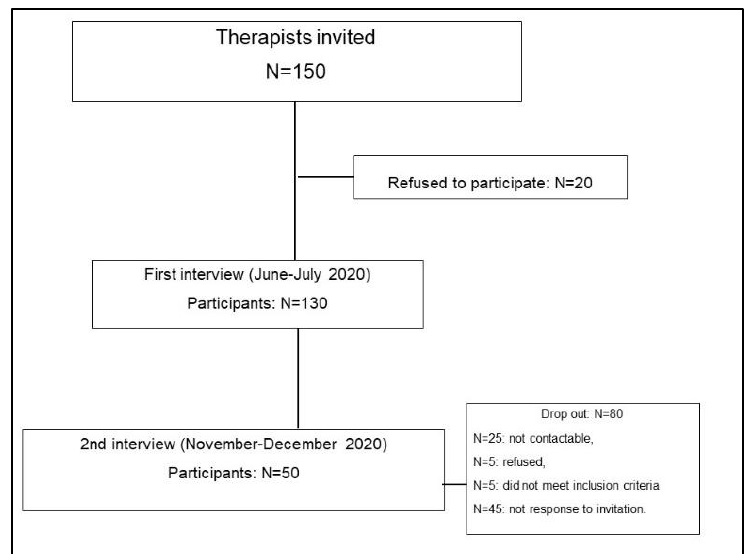
Figure 1. The study flow chart.